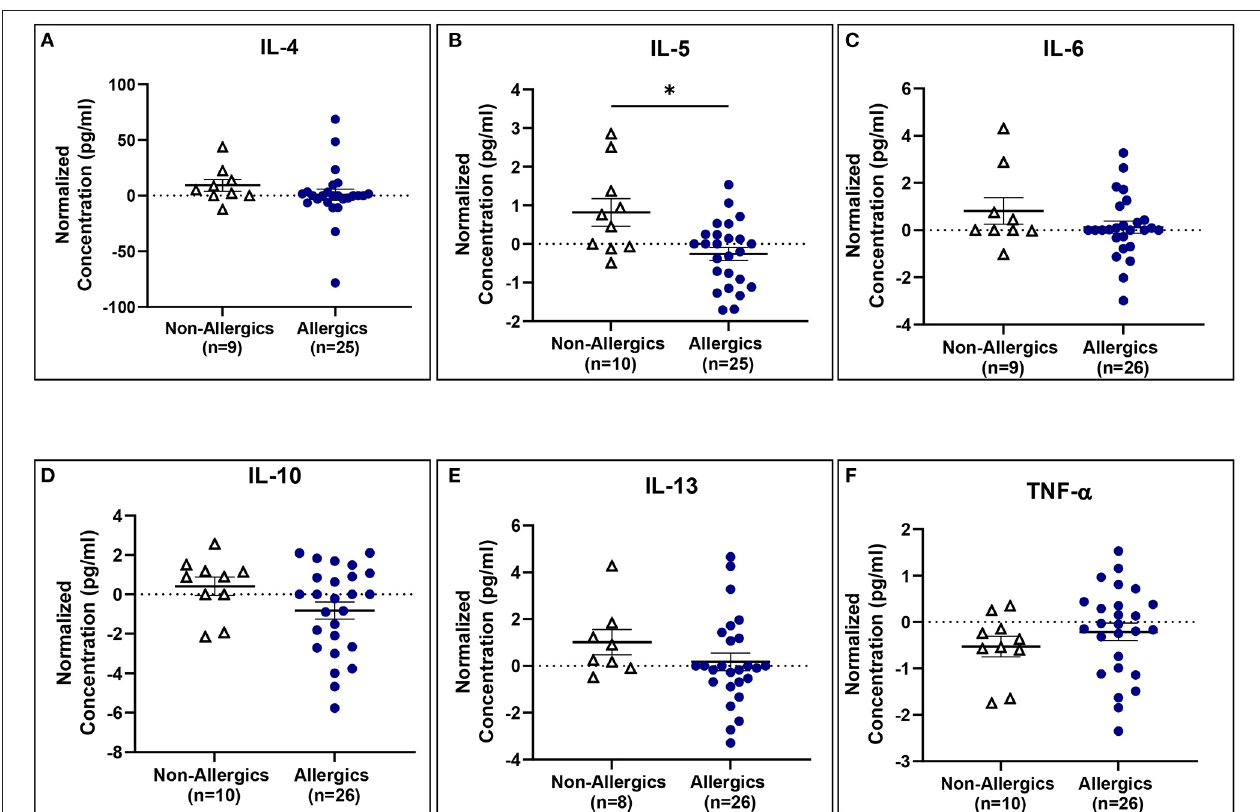
FIGURE 10 | Serum IL-5 concentrations normalized to baseline are significantly reduced for allergics compared to non-allergic participants. Concentrations of IL-4 (A) , IL-5 (B) , IL-6 (C) , IL-10 (D) , IL-13 (E) , and TNF- α (F) normalized to baseline were evaluated pre- and post-HDM exposure for allergic and non-allergic participants. IL-5 concentrations normalized to baseline were significantly decreased for HDM-allergic participants compared to non-allergic controls. * , p <